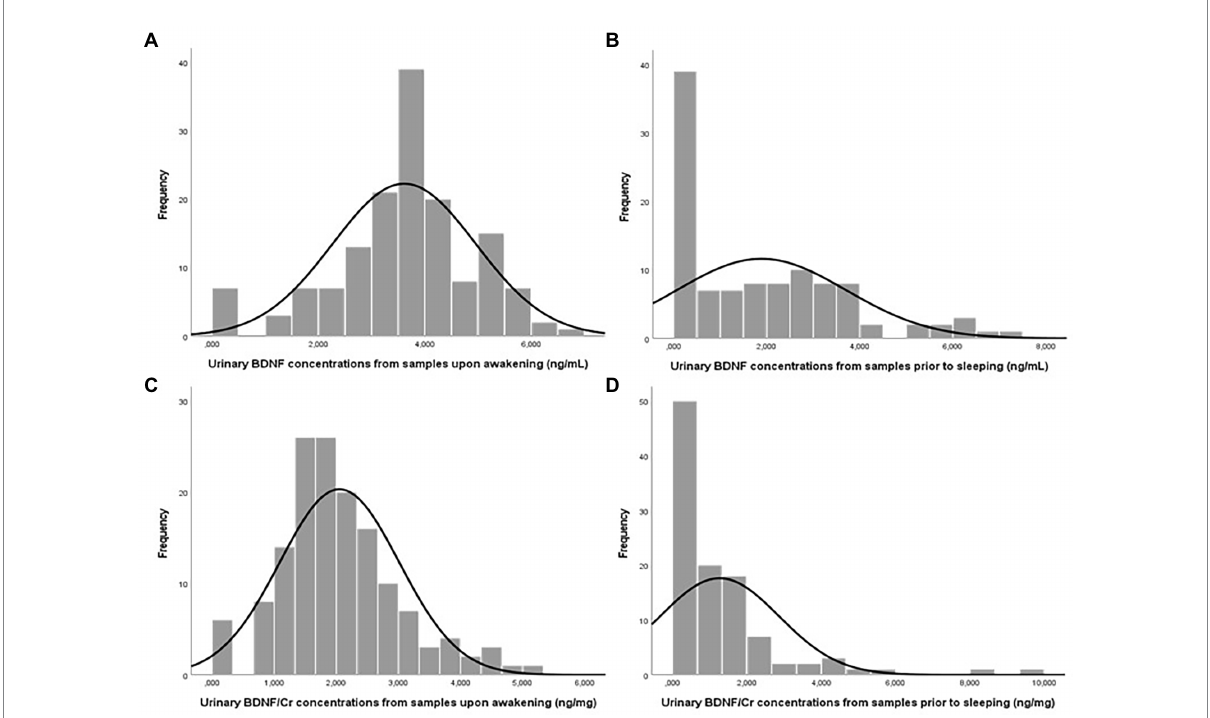
FIGURE 2 Urinary BDNF (ng/ml) and BDNF/Cr (ng/mg) concentrations in male adolescents: Urine samples upon awakening, n = 150 (A,C) and samples prior to sleeping, n = 106 (B,D)